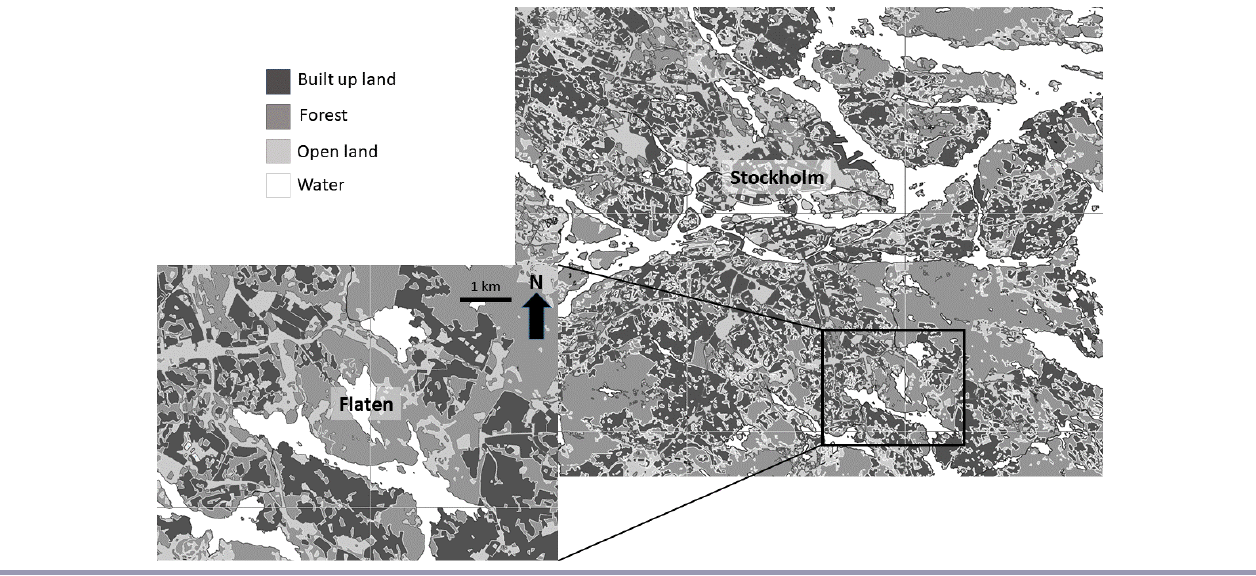
Fig. 1 . Map of the Flaten Landscape and its location in relation to